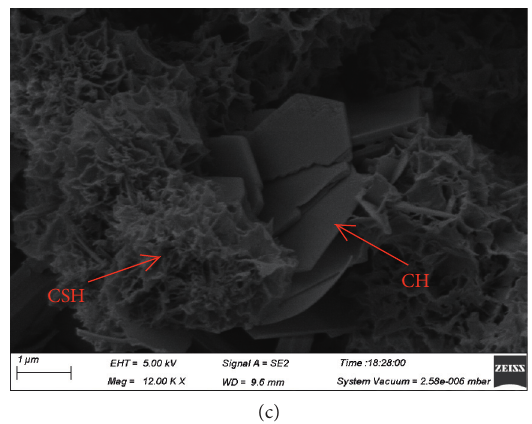
Figure 15: SEM images of the specimen for 28 days: (a) 1000x, (b) 8000x, and (c)